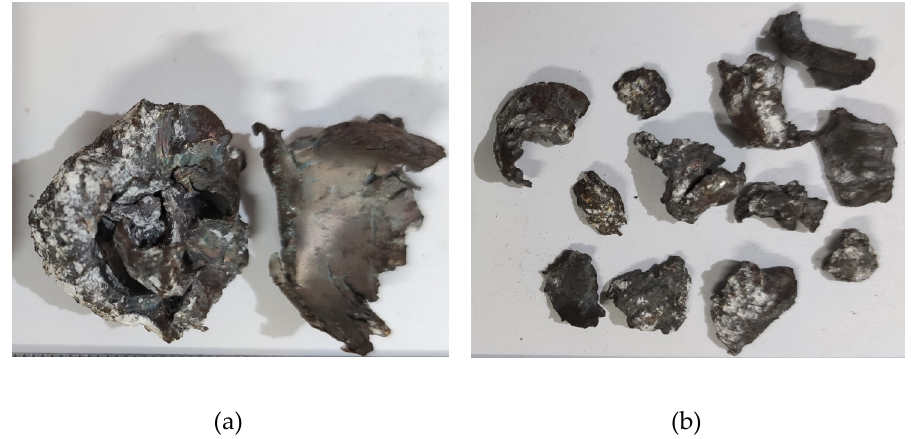
Figure 9. The photographs of the typical recovered projectiles: ( a ) Shot No. 7 ; ( b ) Shot No. 10.